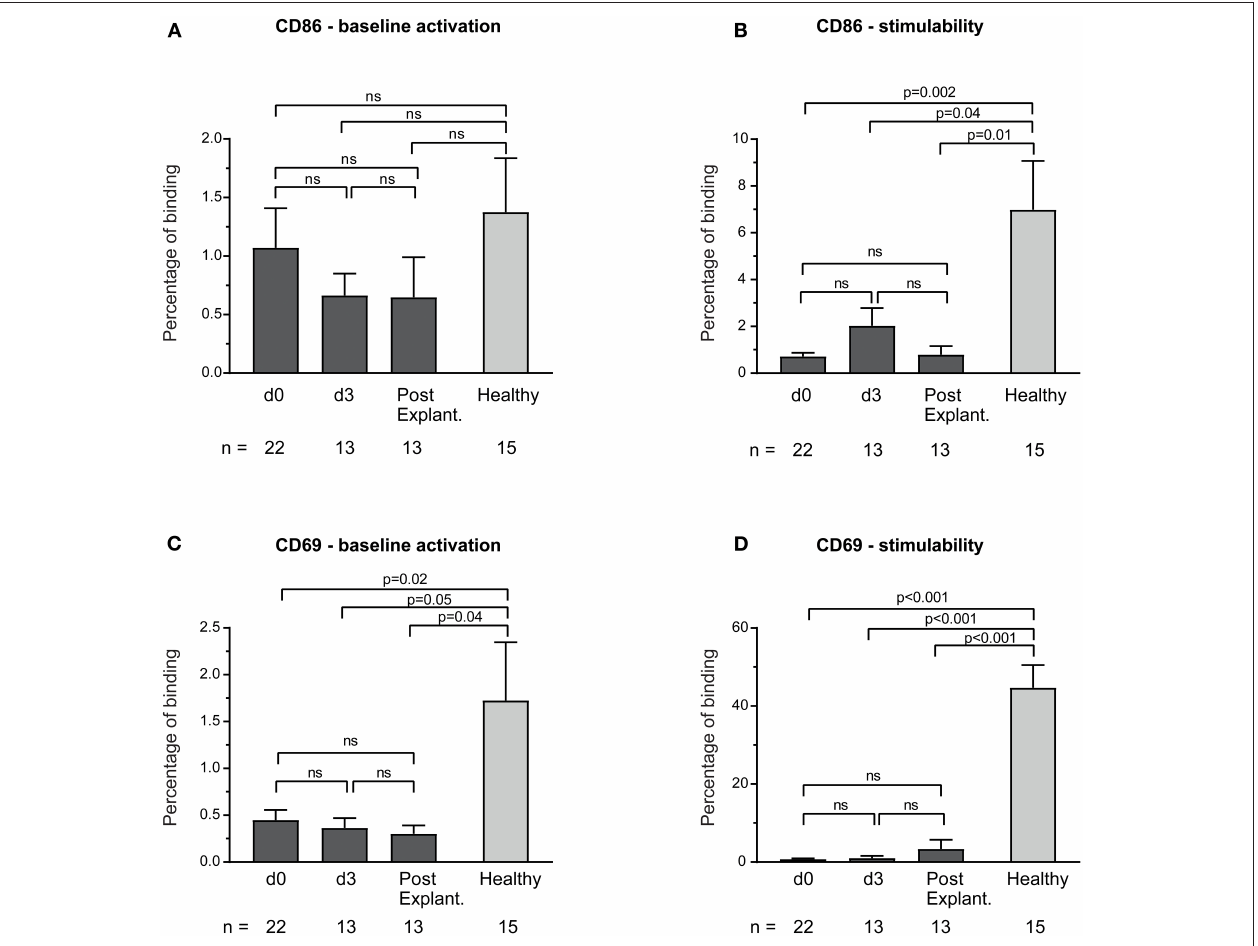
FIGURE 3 | Baseline monocyte activation and stimulability as determined by CD86 (A,B) and CD69 (C,D) surface expression. The number of remaining patients analyzed at each time point during VA-ECMO therapy (d0, d3) and after explantation (post explant.) is presented below the individual bars. Baseline monocyte activation was measured in phosphate buffered saline treated samples. Stimulability was assessed in samples treated with phorbol 12-myristate 13-acetate to induce maximum monocyte activation. CD14 + monocyte CD69 and CD86 surface expression is presented in percentage and was quantified as described in the Materials and Methods section. ns, not significant. Baseline expression levels of CD86 and CD69 were low in healthy controls and patients. Mixed effects models were used to analyze differences between means across different time points (d0, d3, and post explantation vs. each other). Unpaired t -tests were used to analyze differences of means at single time points. Data are presented as mean ±